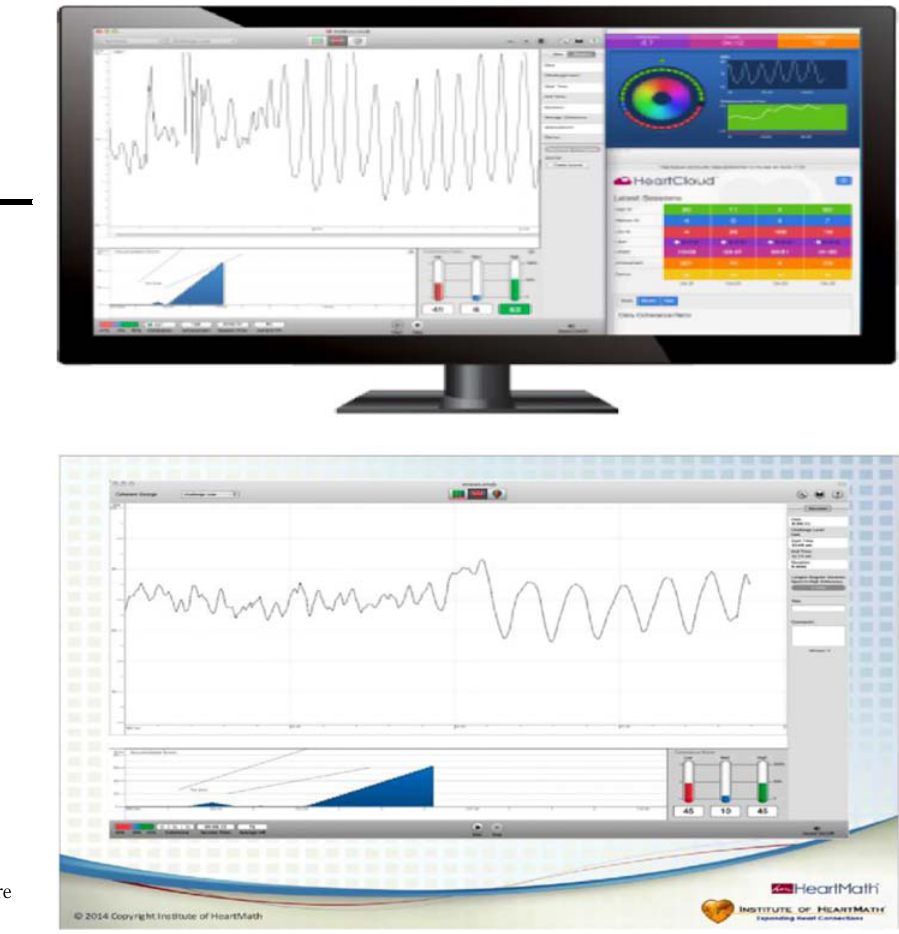
Figure 1. EmWave Pro Plus Computer Hardware and HRV Monitor Source: Institute of HeartMath (2016) heart rate differences for each measured cycle (McCraty and Watkins, 1996; Task force of the European Society of Cardiology and the North American Association of Pacing and Electrophysiology, 1996). Finally, normalized coherence is a frequency domain measure of coherence where power in the coherence peak of the power spectrum density is divided by total power. This measure represents the ratio of coherence relative to total power and ranges from 0 to 100 (McCraty and Watkins, 1996). Moreover, a coherent heart rhythm is visualized as a harmonic sine-wave-like signal with a narrow, high-amplitude peak in the low frequency (0.04 – 0.26 Hz) region of the HRV spectrum. Coherence is evaluated by detecting the maximum (coherence) peak in the 0.04 – 0.26 Hz range, calculating the integral in a window 0.030 Hz wide, centered on the highest peak in that region, and then calculating the total power of the entire spectrum (Shaffer et al. , 2014). The emWave Pro Plus is based on decades of research, incorporating the patented HRV measurement and has been used by tens of thousands of people in over 85 countries (Institute of HeartMath, 2016).